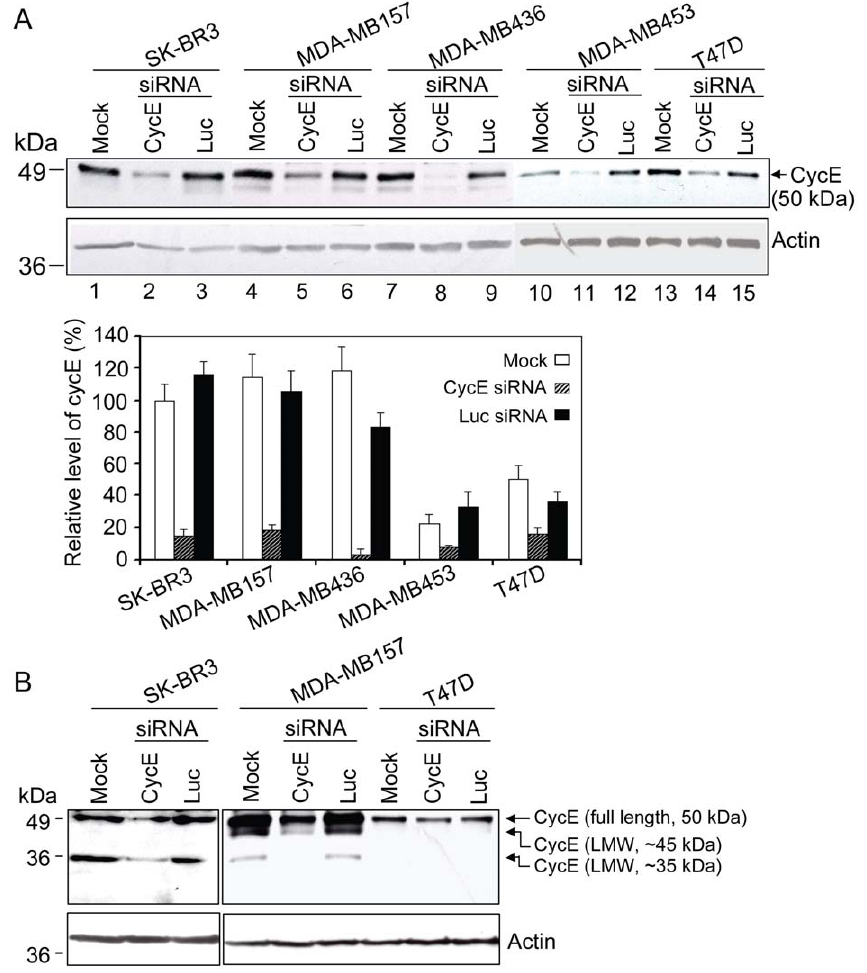
Figure 1. CycE siRNA is able to remarkably suppress cycE overexpression in breast cancer cell lines. A ) Inhibition of cycE overexpression by cycE siRNA. Indicated cells were transfected with siRNA oligos targeting on either cycE or luciferase (Luc, control). Cells were harvested two days after transfection. The protein lysates were subjected to Western blotting analysis by using anti-cycE and anti-Actin antibodies, respectively (top panel). CycE protein levels (full length) from cycE or luc siRNA-treated cells were normalized by Actin. The normalized density of cycE in the mock SK- BR3 was arbitrarily set at 100%, and the relative level of cycE in other samples was obtained by comparing those normalized densities of cycE to that of cycE in the mock SK-BR3 (bottom panel). B ) Suppression of the expression of LMW isoforms by cycE siRNA. The indicated cells were transfected with or without siRNA, and the whole lysates were collected and subjected to anti-CycE Western blot analysis. In SK-BR3 and MDA-MB157 cells, although LMW isoform pattern of cycE was different, the LMW isoforms as well as the full length cycE were inhibited by cycE siRNA. The LMW isoforms of cycE were undetectable in T47D.